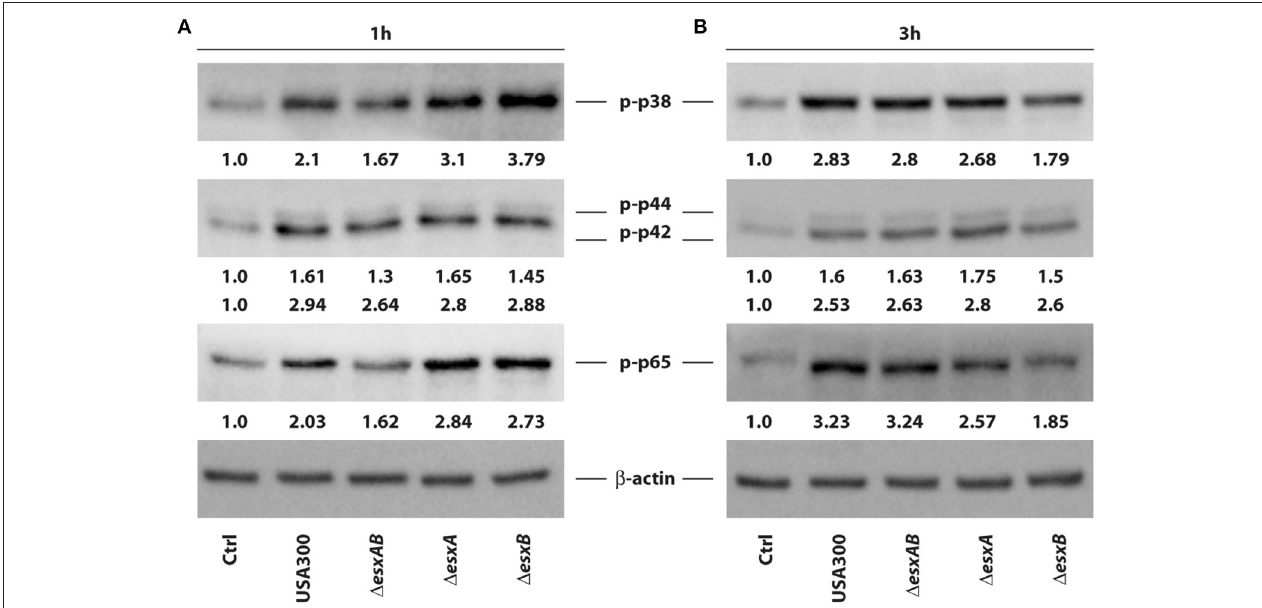
FIGURE 5 | Activation of p38, p44/42 MAPK and NF-kB p65 in DC infected with wild type USA300 or esx mutants. The activation of intracellular pathway involving p38, p42/44 MAPK, and NF-kB p65 subunit was investigated by western blotting analysis of the phosphorylated isoforms in whole cell extracts prepared from DC infected for 1 (A) and 3 h (B) with wild type USA300 or esx mutants. β -actin levels were analyzed as control for protein loading. Fold changes of each analyzed protein, indicated at the bottom of each immunoblot, were calculated by dividing values obtained in infected conditions with those of the uninfected counterpart. A representative experiment, out of 3 independent experiments performed that yielded similar results, is shown.